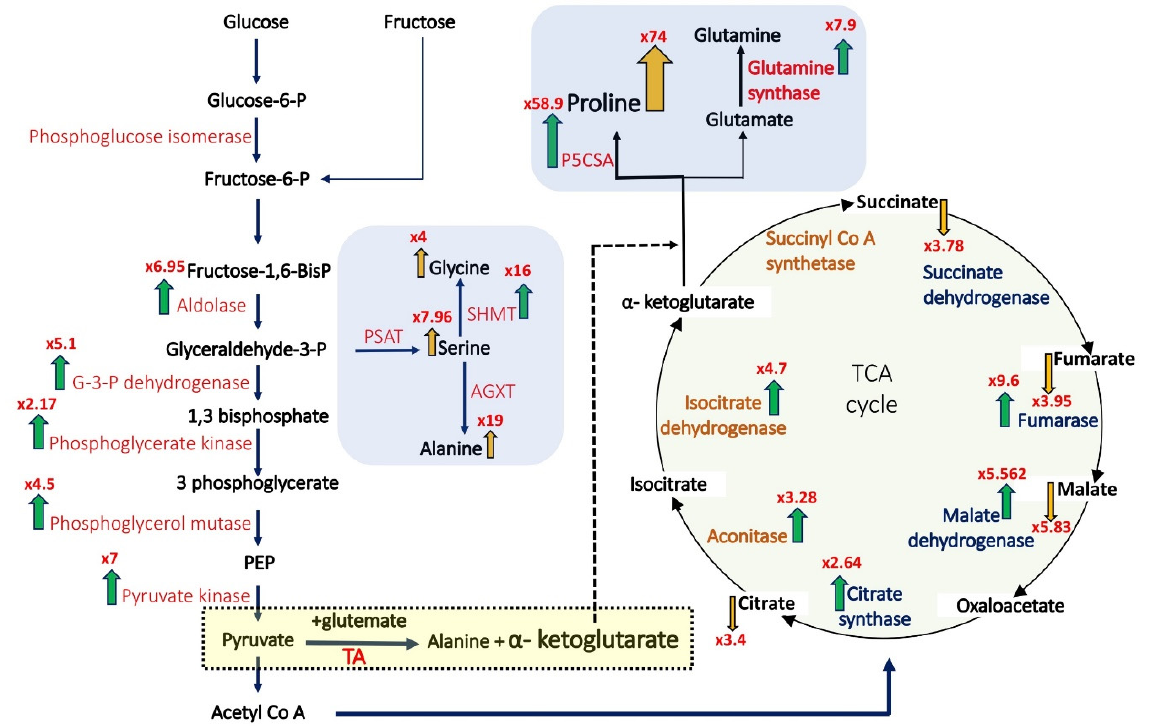
Figure 4. Proteome-metabolome correlation analysis. The metabolites and the enzymes present in pericarp extracts of control and salt-treated B. juncea plants involved in the glycolysis pathway, TCA cycle, and amino acids synthesis are shown. Green arrows pointing upward indicate the up-accumulation of enzymes in salt-treated pericarps. Brown arrows pointing upward and downward indicate up-accumulation and down-accumulation of metabolites, respectively. Numbers at the arrow head indicate fold change compared to control pericarps. P5CSA, Delta-1-pyrroline-5-carboxylate synthase A; PSAT, phosphoserine aminotransferase; SHMT, serine hydroxymethyl transferase; AGXT, Alanine glyoxylate aminotransferase; TA, transaminase. Table 2. Relationship between proteins and metabolites. Fold change (FC) ratio of proteins and me- tabolites between treatments and control ( p value < 0.05). P, protein; M, metabolite. No correlation between protein and metabolite levels is colored red.